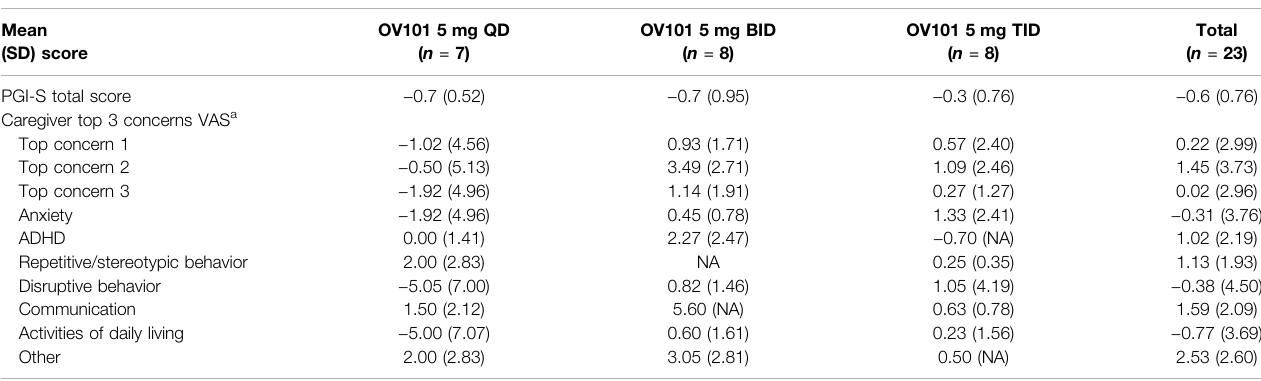
TABLE 5 | Change in exploratory ef fi cacy measures from baseline to week 12. Mean (SD)